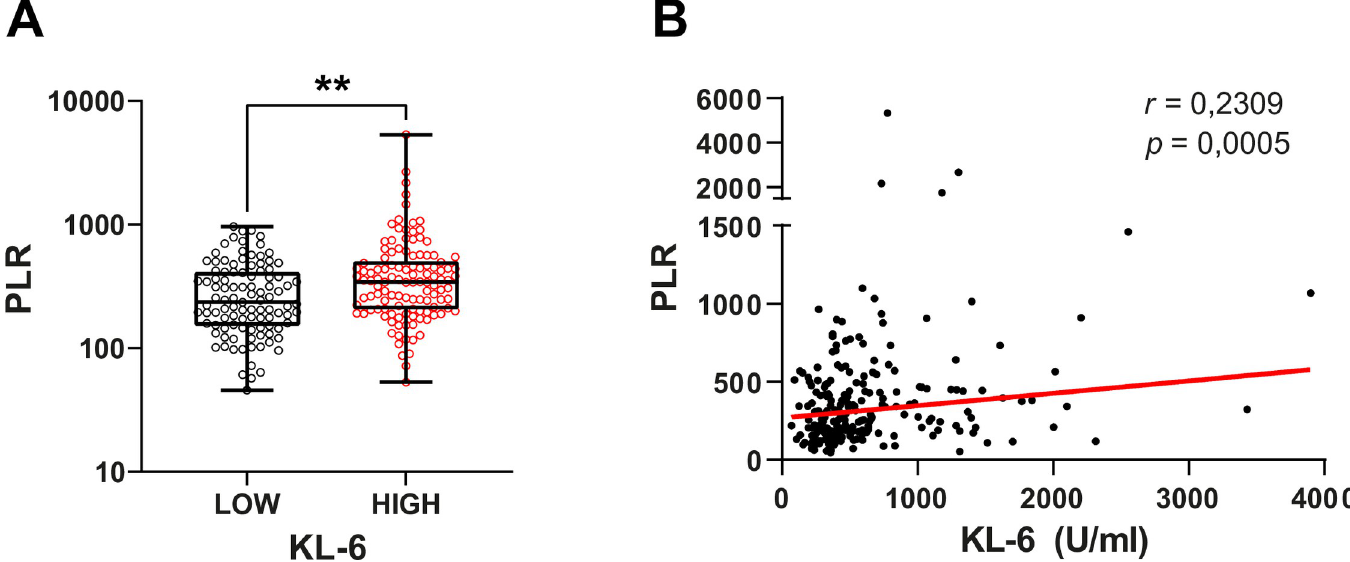
Fig 4. Correlation between KL-6 and PLR levels in COVID-19 patients. ( A ) Comparison of PLR levels between COVID-19 patients with high and low KL-6 levels. High KL-6 patients display a significantly higher PLR levels. Data are analyzed using a non-parametric two-tailed Mann-Whitney test. �� P < 0.01. ( B ) Correlation between KL-6 and PLR levels. Data are analyzed using Spearman